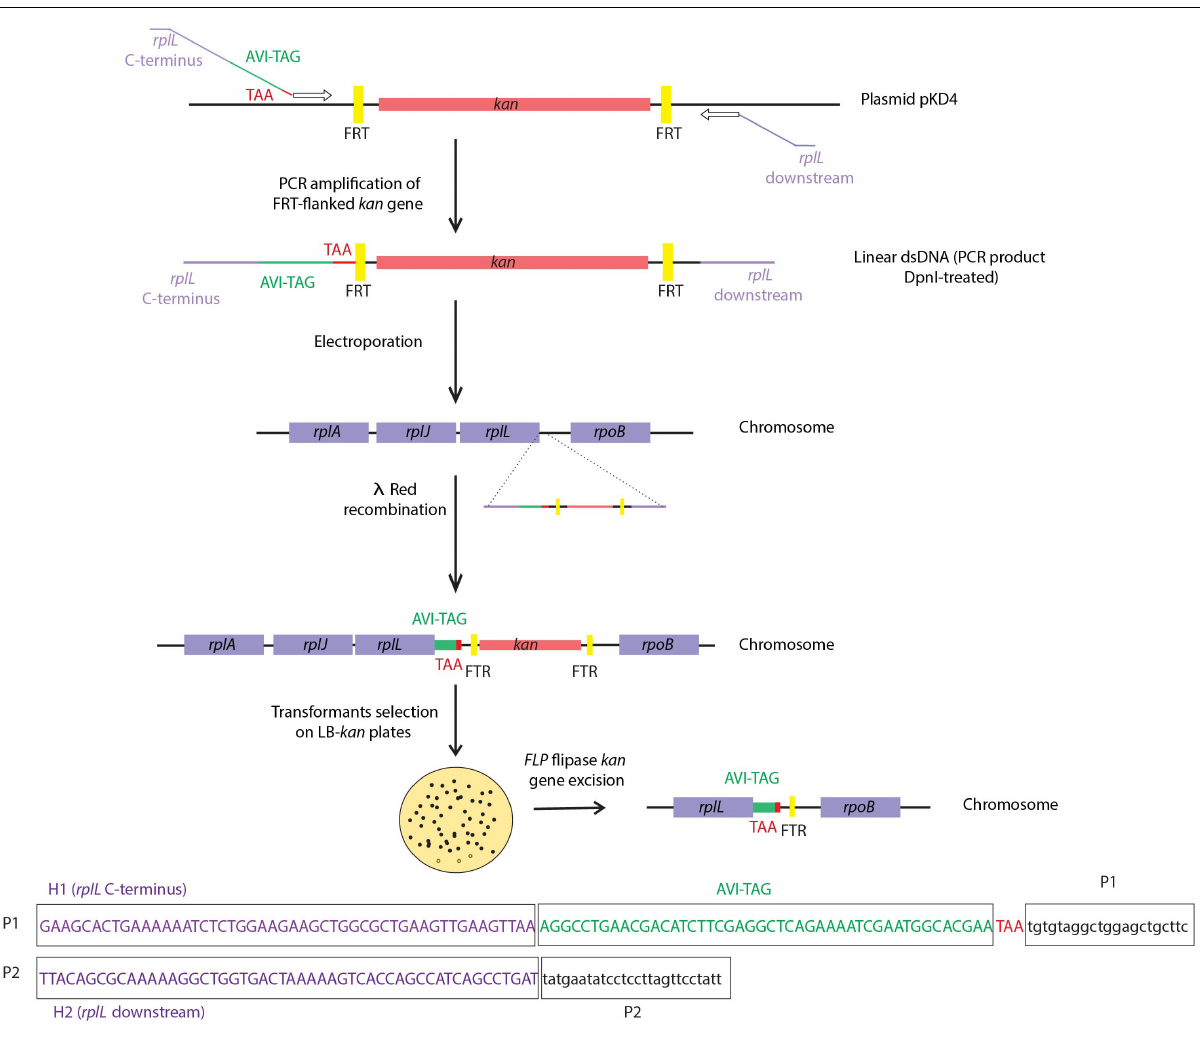
FIGURE 3 | Tagging of the chromosomal rplL gene in Salmonella enterica strain SL1344 and FLP-mediated excision of the antibiotics resistance cassette. The resistance marker kan , flanked by FRT regions, is PCR-amplified from the plasmid pKD4 by making use of primers P1 and P2, with rplL C-terminus and downstream homology regions (H1 and H2), respectively. Primer P1 also contains a tag (i.e., AVI-tag) sequence followed by a translation stop codon (TAA). The resulting linear dsDNA PCR product flanked with sequences homologous to the target region is electroporated into competent S. enterica expressing λ red recombination genes. Upon selection of kanamycin resistant transformants, flippase (FLP) mediated kan gene excision is induced, leaving an FRT scar sequence. In line with the tagging of E. coli rplL performed in Ederth et al. (2009), tagging of rplL of Salmonella enterica strain SL1344 was performed in house